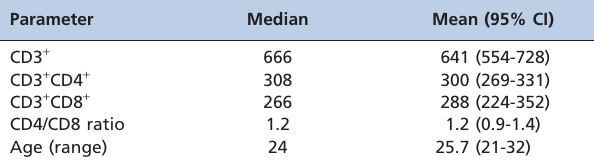
Table 2 - Median and mean (95% CI) of T lymphocyte counts (cells/ m l) in the peripheral blood of peacekeepers (n =14) with reduced CD4 counts after the operational mission in